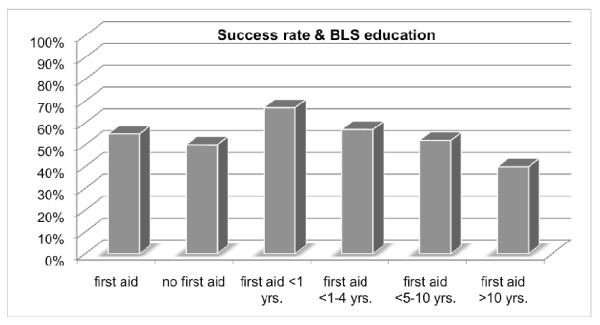
Rate of success and previous BLS education. Data are presented as percentages. No significant difference was found between. BLS providers and participants without BLS training (P = 0.84).